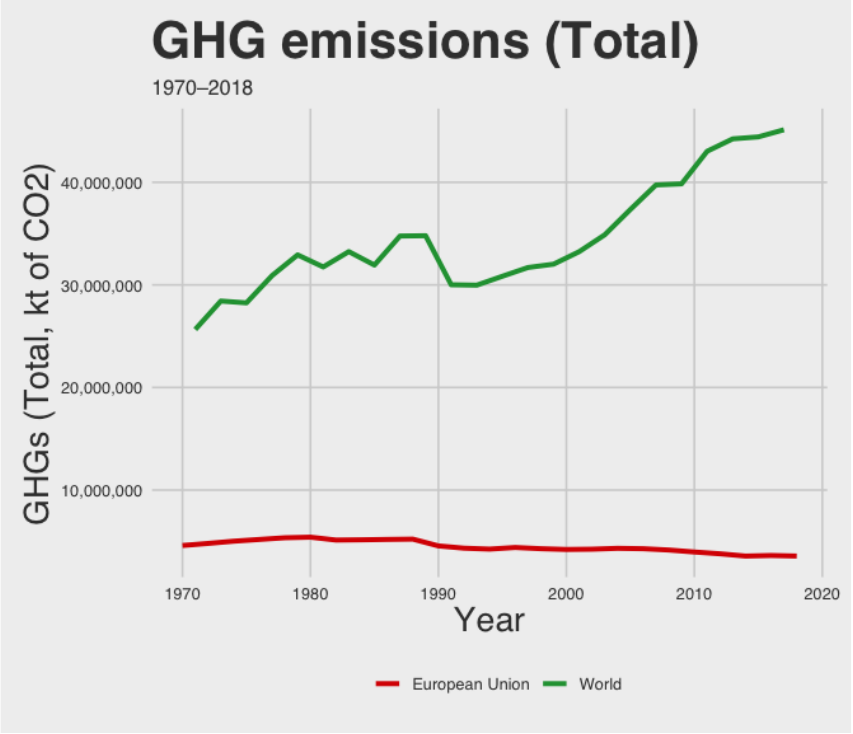
Figure 1. Historical evolution of GHGs over 1970–2018. Authors’ representation. Data source: World Development Indicators (WDI).